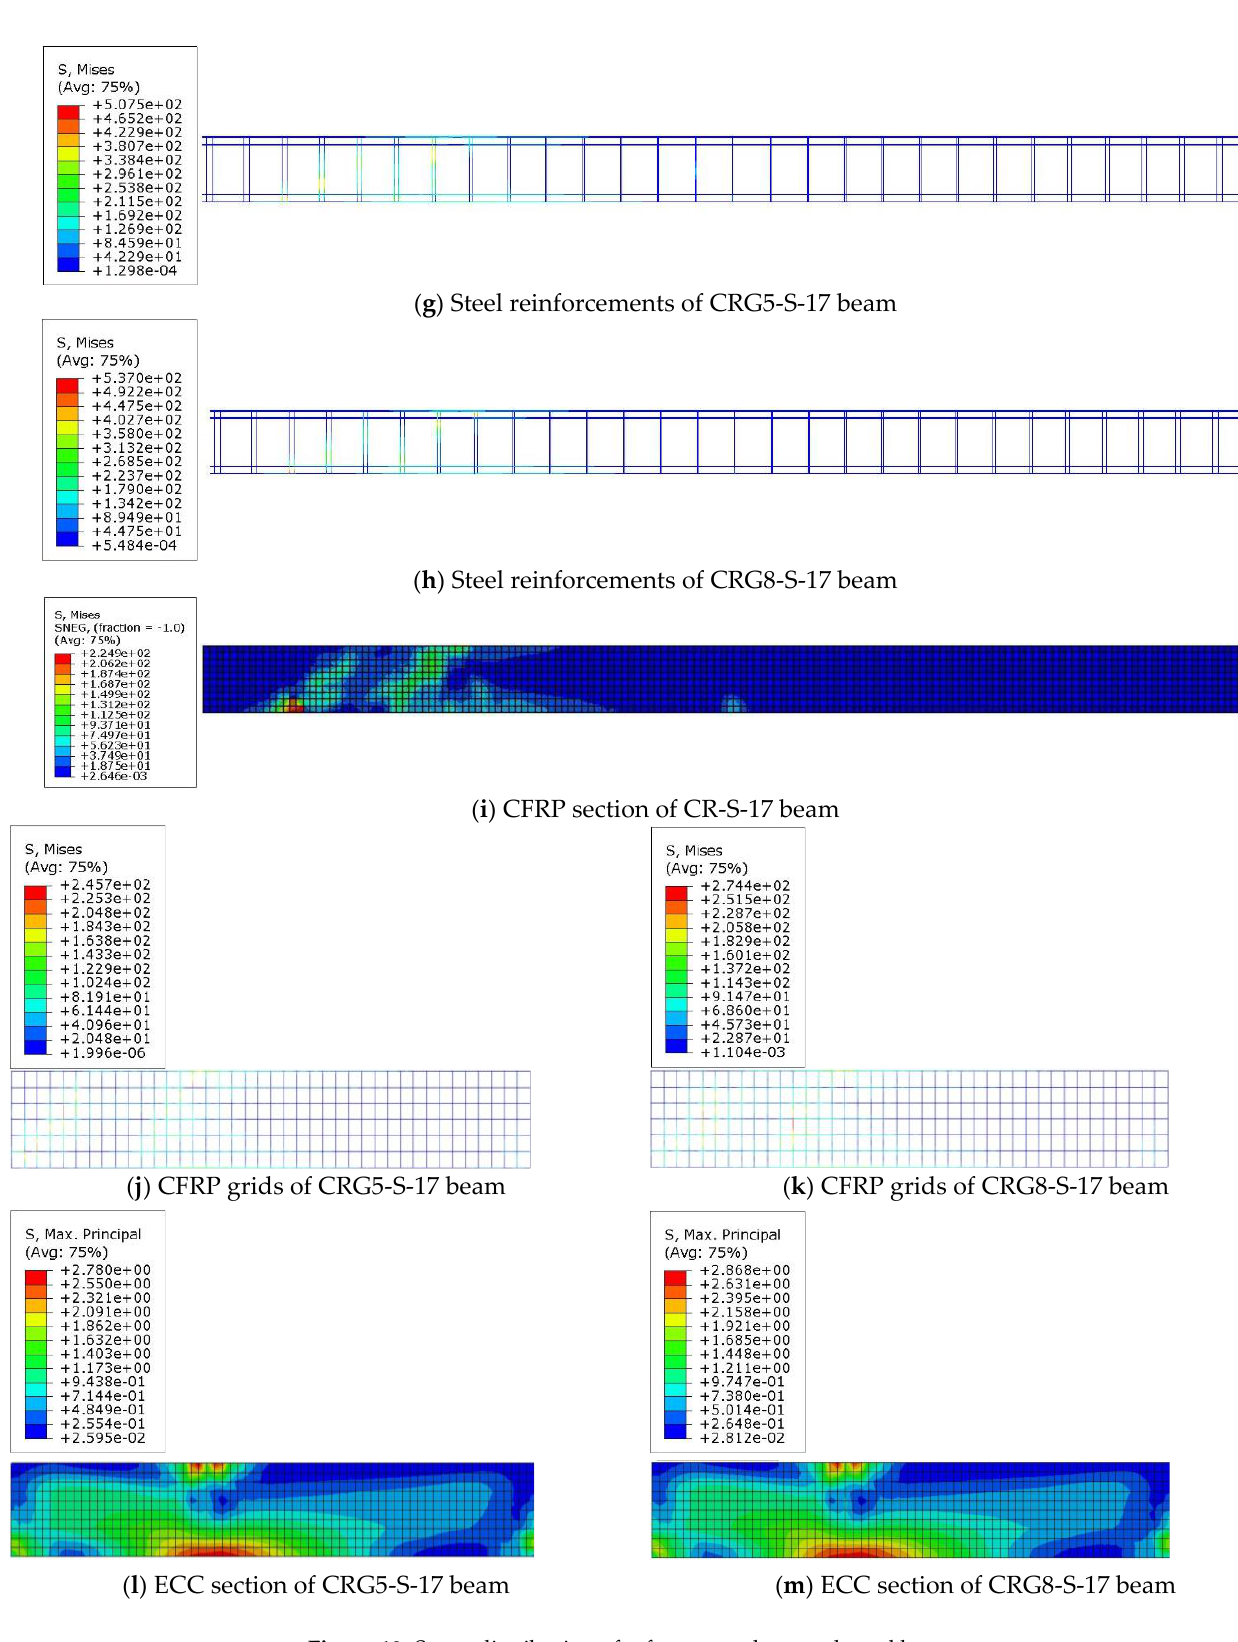
Figure 10. Stress distribution of reference and strengthened beams.